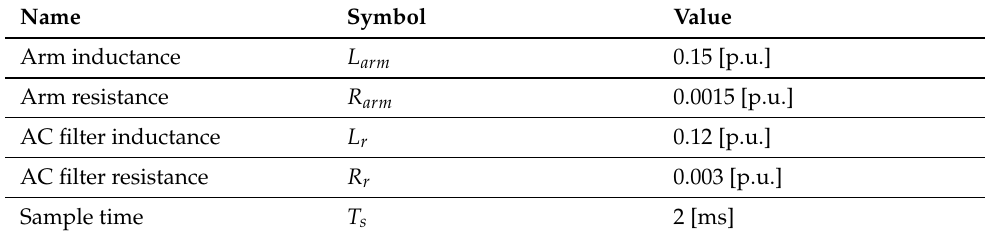
Table 6. Parameters of the MMC for Indirect implicit MPC validation simulations.